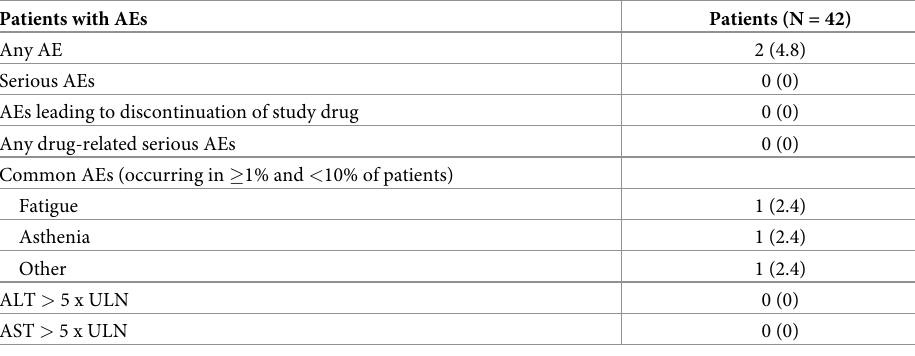
Table 3. Adverse